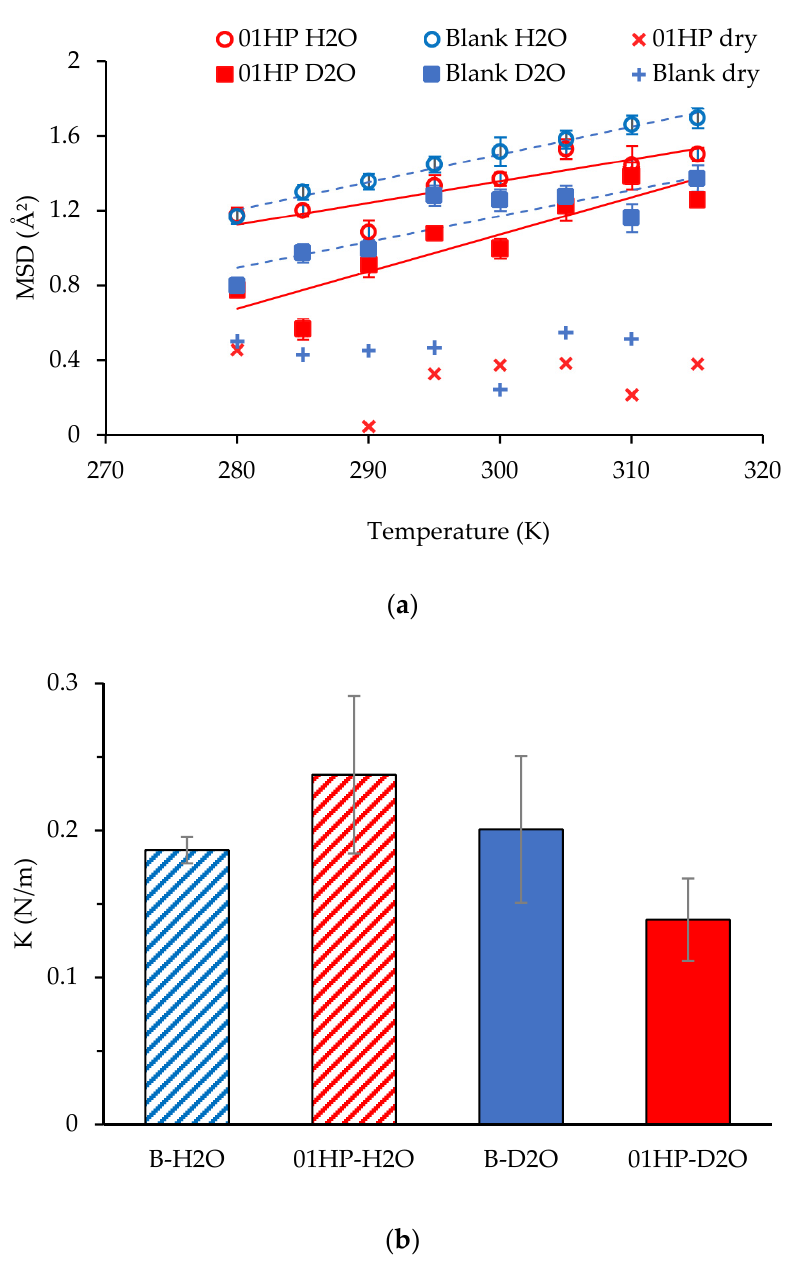
Figure 8. Panel ( a ): MSD values (for B and 0.1 HP scaffolds, dry (crosses) and hydrated in either H 2 O (blue) or D 2 O (red). Panel ( b ): local resilience determined for HP-free or HP-doped scaffolds (mean values ± s.d.; n =